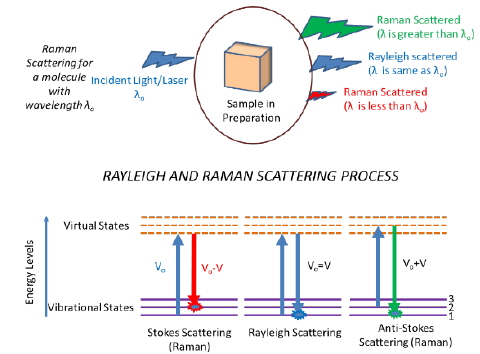
Figure 1. Principle of Raman Spectroscopy: Concept of Rayleigh and Raman